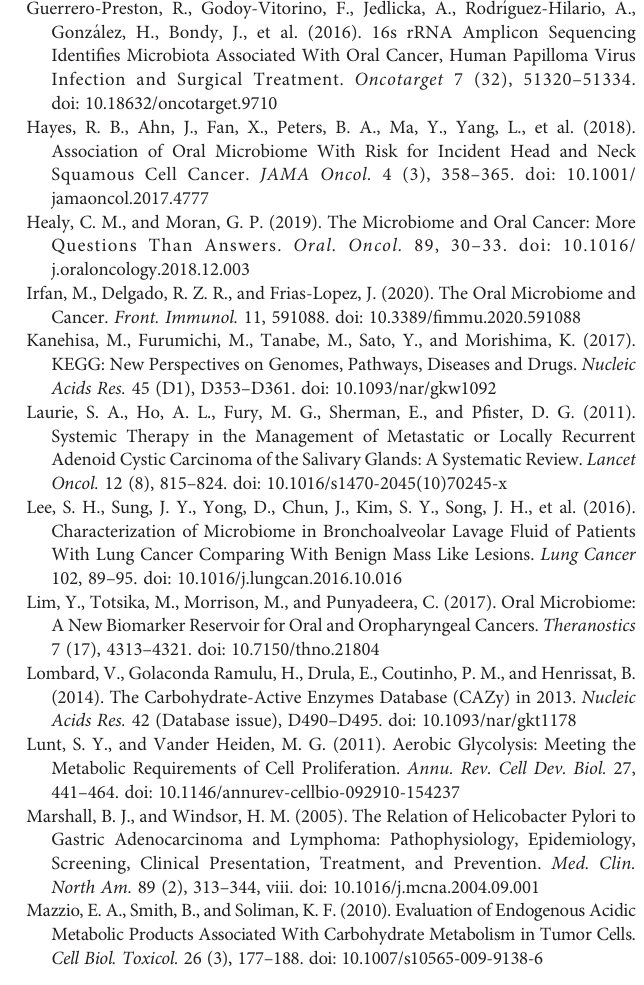
Supplementary Figure 1 | The rarefaction curves. The x axis indicates the number of reads sampled. The y axis indicates the Shannon index of OTU level. Different colors represent different